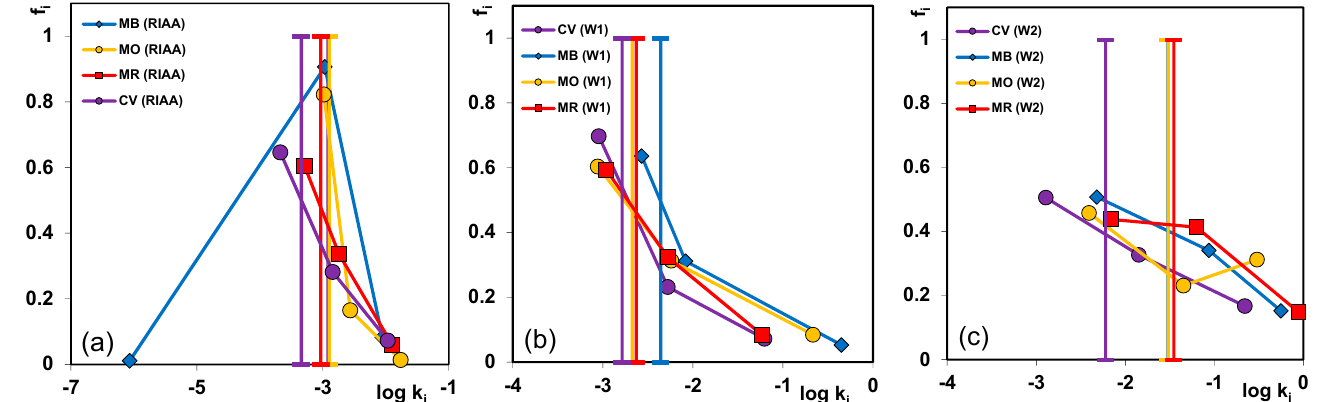
Figure 11. Parameter spectra for the multi-exponential equation for the dye adsorption kinetics on the activated carbon RIAA ( a ); W1( b ) and W2 ( c ).